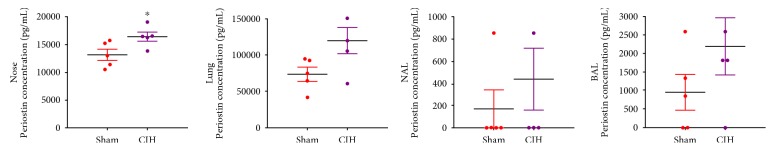
Changes in periostin levels. The level of periostin was markedly increased by exposure to chronic intermittent hypoxia (CIH), compared to that of the Sham group, in all samples. Among them, periostin in the nose tissue was significantly elevated by 4 weeks of CIH. ∗p < 0.05 was considered as statistically significant compared to the sham groups.